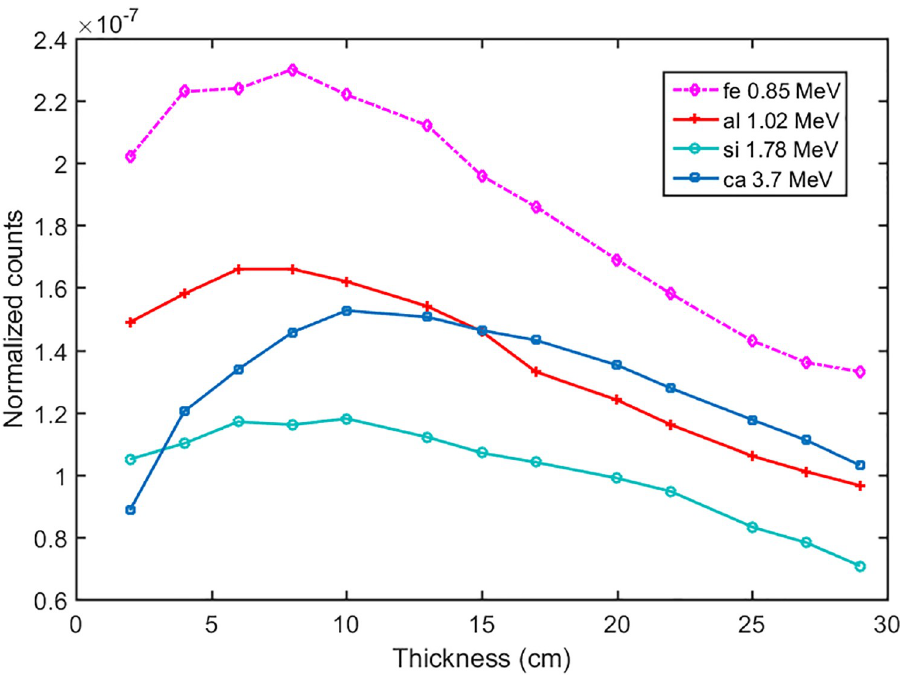
Fig 11. The characteristic peaks as a function of the thickness of the cement samples.